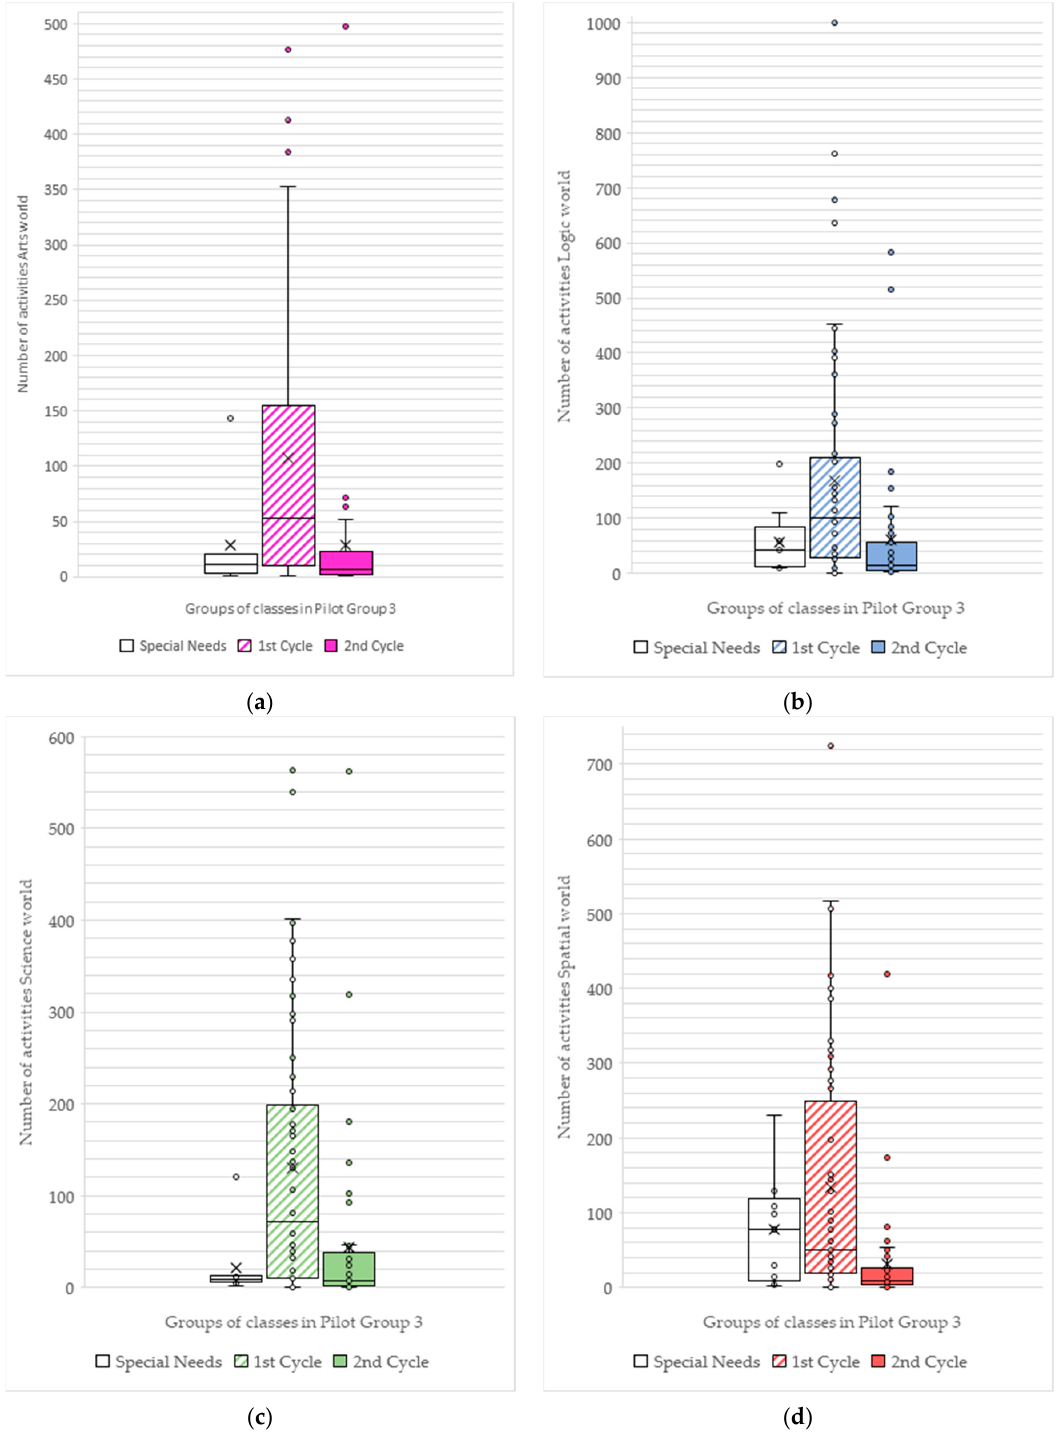
Figure 10. Descriptive statistic representation of significant results of activities played with one-way ANOVA analysis. ( a ) Figure of significant results with activities played among class groups in the Arts world. ( b ) Figure of significant results with activities played between class groups in the Logic world. ( c ) Figure of significant results with activities played between class groups in the Science world. ( d ) Figure of significant results with activities played between class groups in the Spatial world.